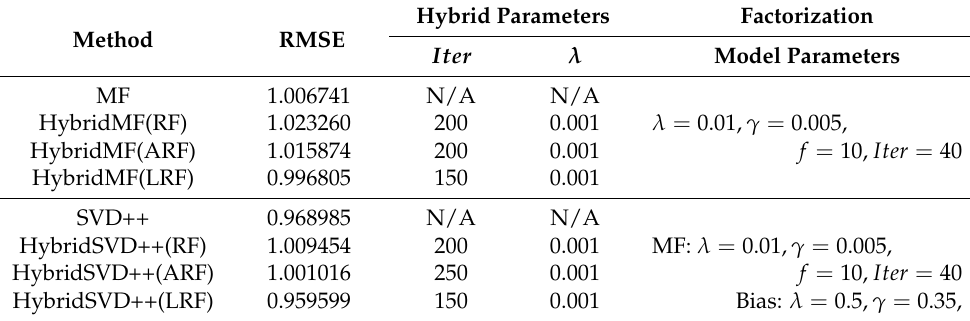
Table 5. Comparison of results (Hybrid model).